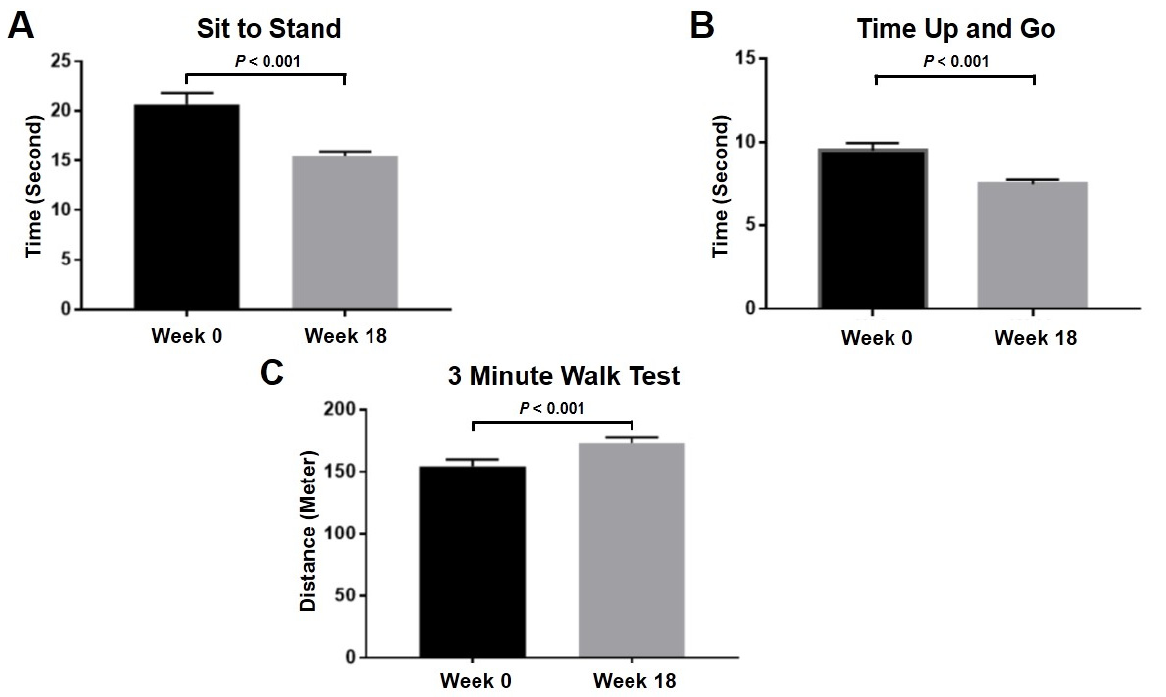
Figure 4. Comparison of physical performance at 0 and 18 weeks following intra-articular PRP injection in knee OA patients: ( A ) sit to stand; ( B ) time up to go; ( C ) 3 min walk test.